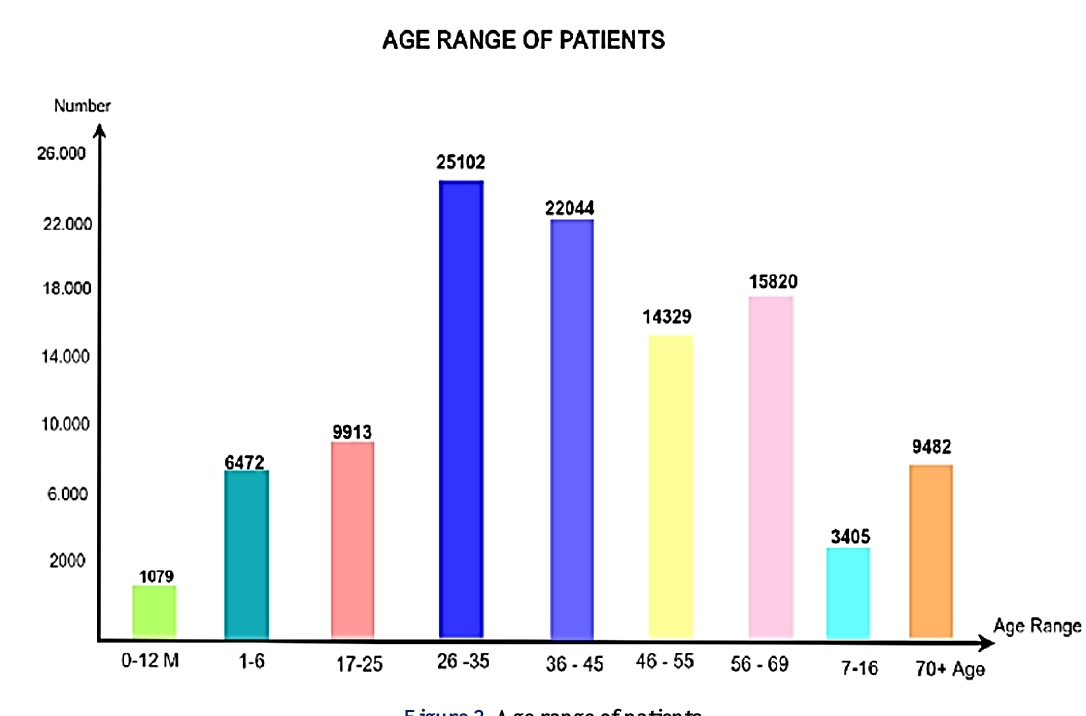
Figure 2. Age range of